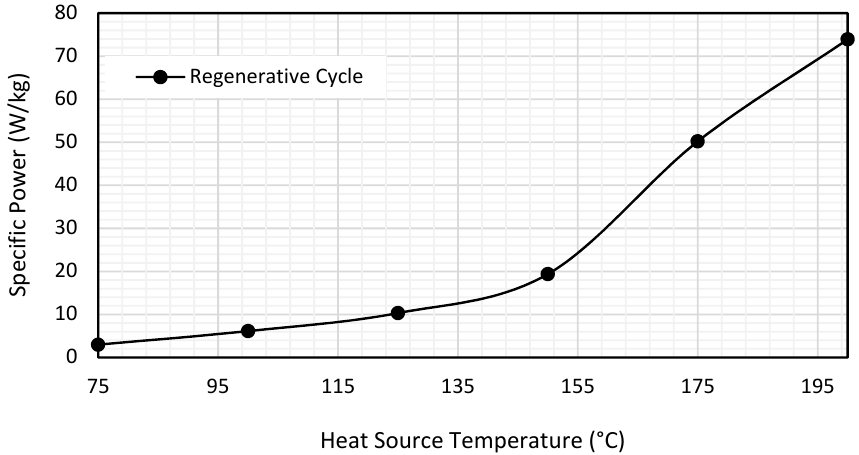
Figure 14. Variation in the Specific Power of the Non-Dynamic Cycle with varying heat source temperature with Beijing’s ambient conditions.